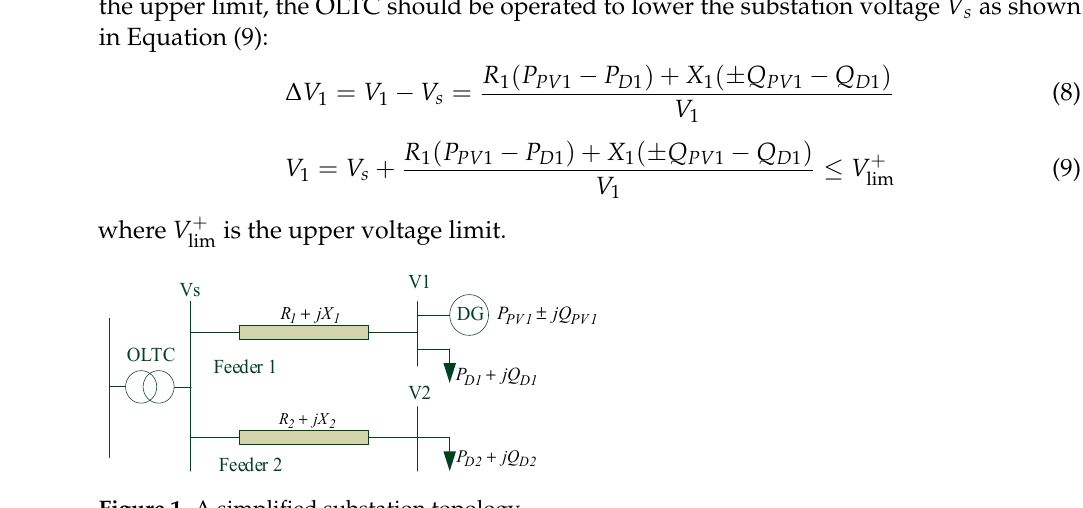
Figure 1. A simplified substation topology.